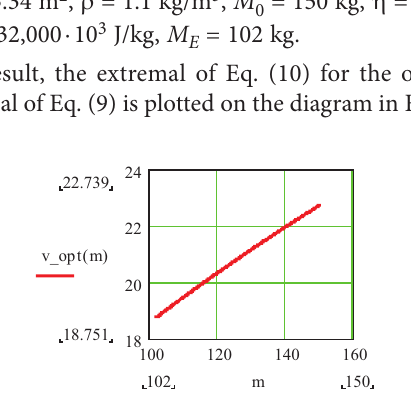
Figure 2. Optimal speed as a function of the variable mass of the flying